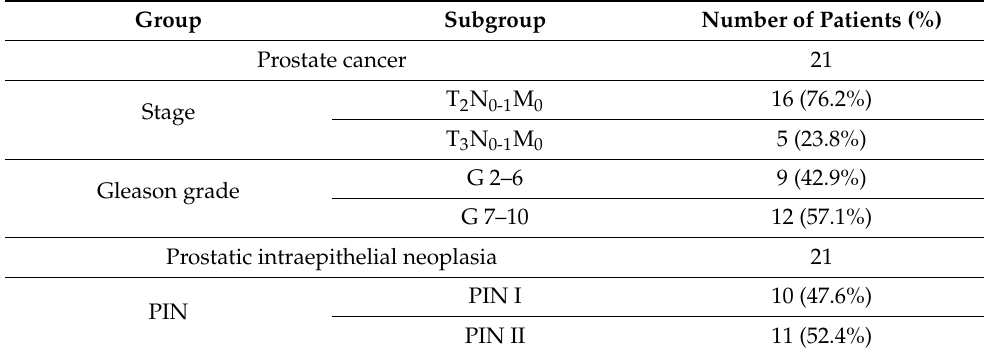
Table 2. Description of the group of patients with prostate